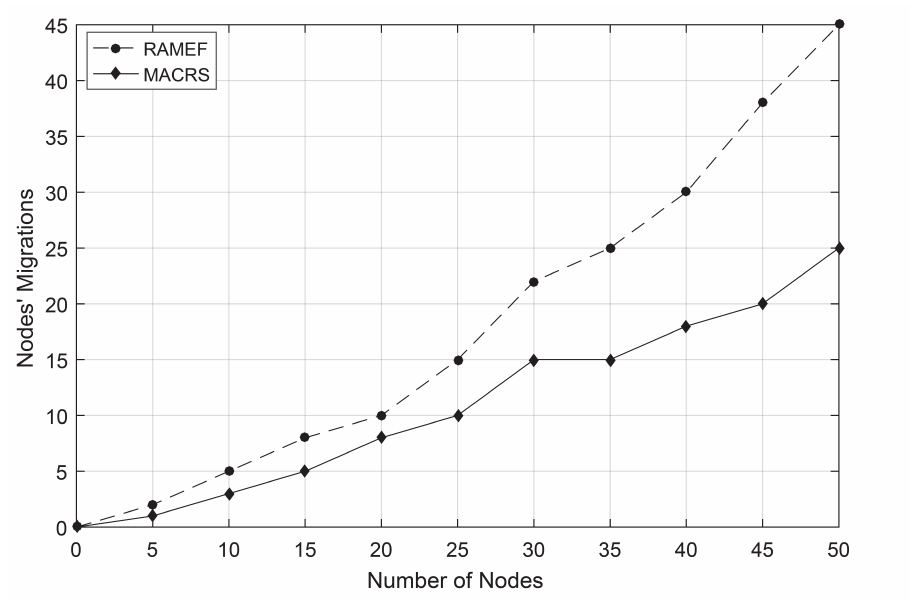
Figure 10. Number of migrations for a variable number of